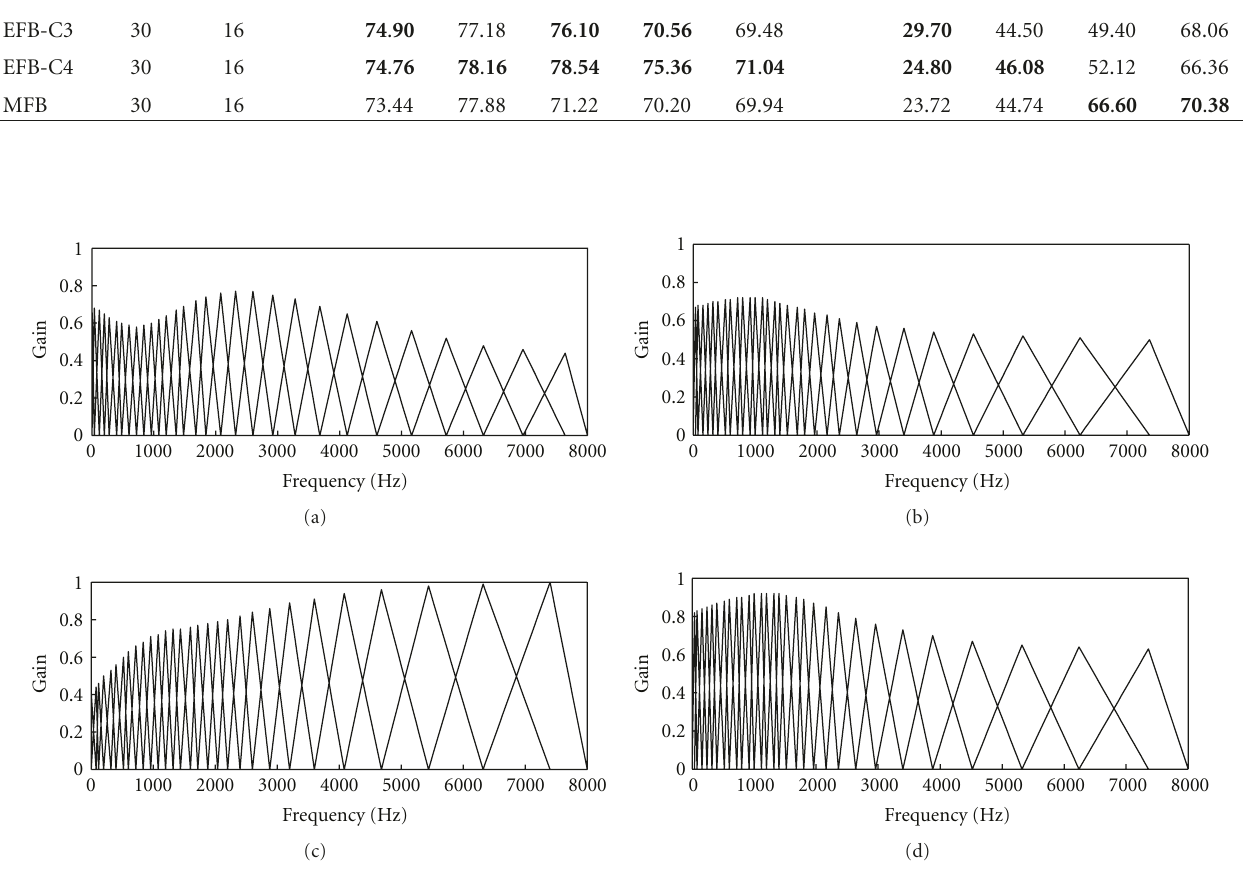
Figure 6: Evolved filterbanks obtained in the optimization of filter center positions and amplitudes simultaneously and using clean